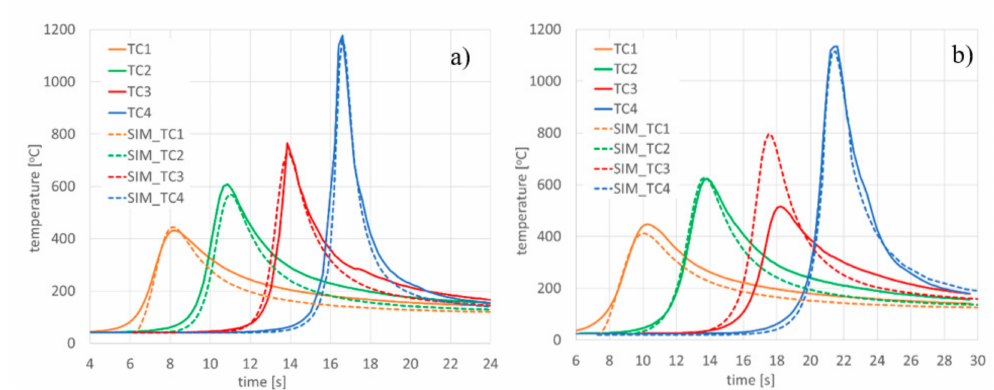
Figure 26. Comparison of recorded and calculated thermal cycles on the bead-on-plate laser welding process performed on 10-mm AISI304 steel samples using the ROFIN DL020 high-power diode laser with ( a ) TC3 and ( b ) TC4 samples. TCx: thermal cycles recorded during the welding process; SIM_TCx: thermal cycles obtained from numerical